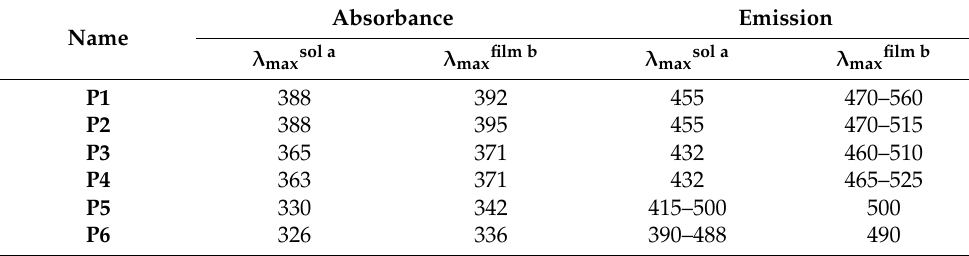
Table 2. Sum up of the polyazomethines optical properties, in solution and in film.